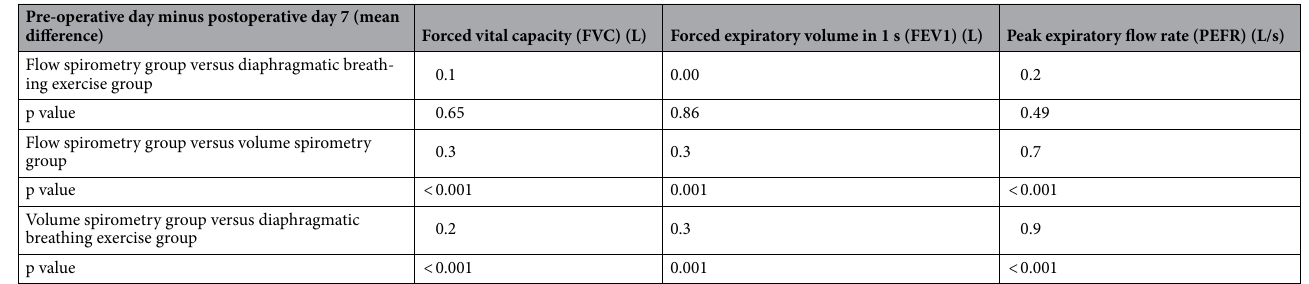
Table 6. Show the difference among the three intervention groups in forced expiratory volume in 1 s (FEV1), forced vital capacity (FVC) and peak expiratory flow rate (PEFR) between preoperative day and postoperative day 7. p < 0.001 highly